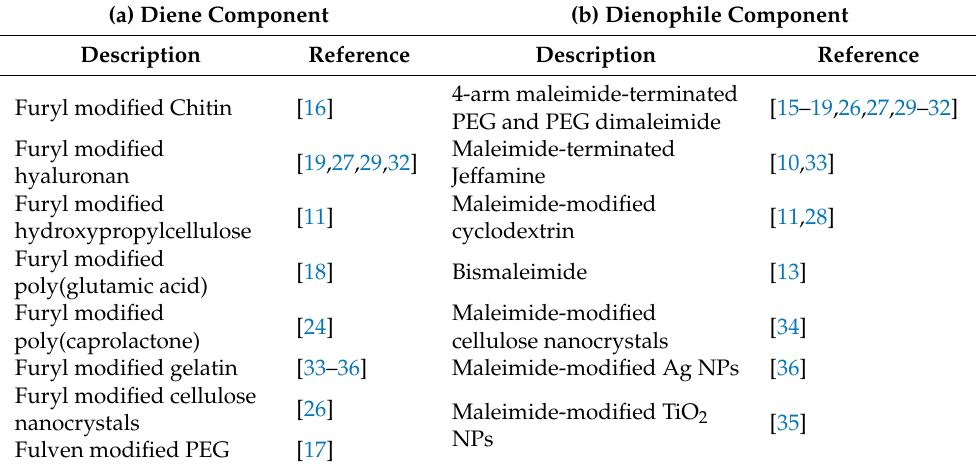
Table 1. Components for DA-based hydrogels. Diene (a) and dienophile (b) components, which are commonly used for hydrogel